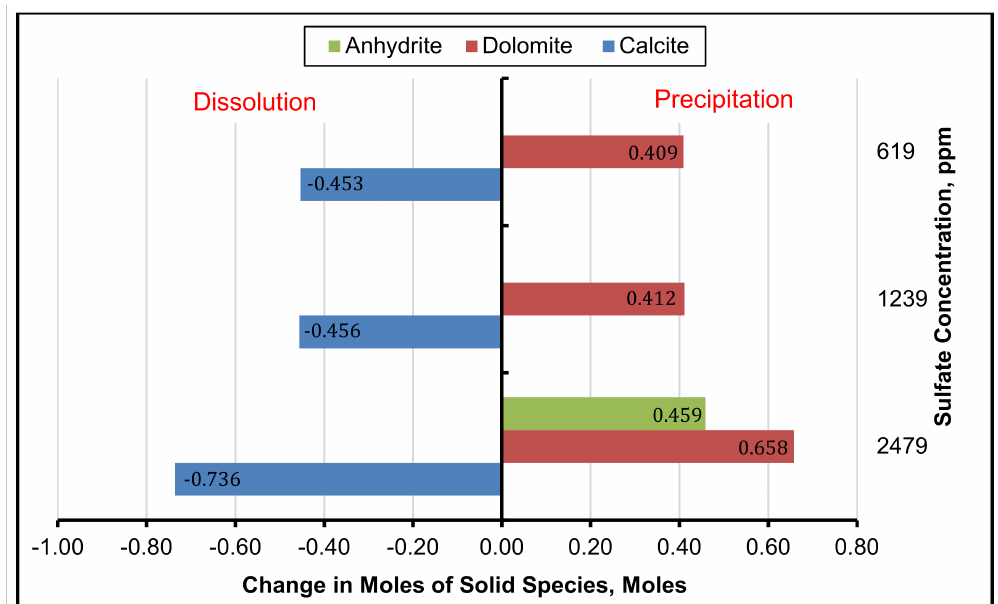
Figure 9. Effect of sulfate concentration on solid species for the first gridblock at 6 PVs with formation and injected water temperatures fixed at 200 ◦ C and 100 ◦ C, respectively.